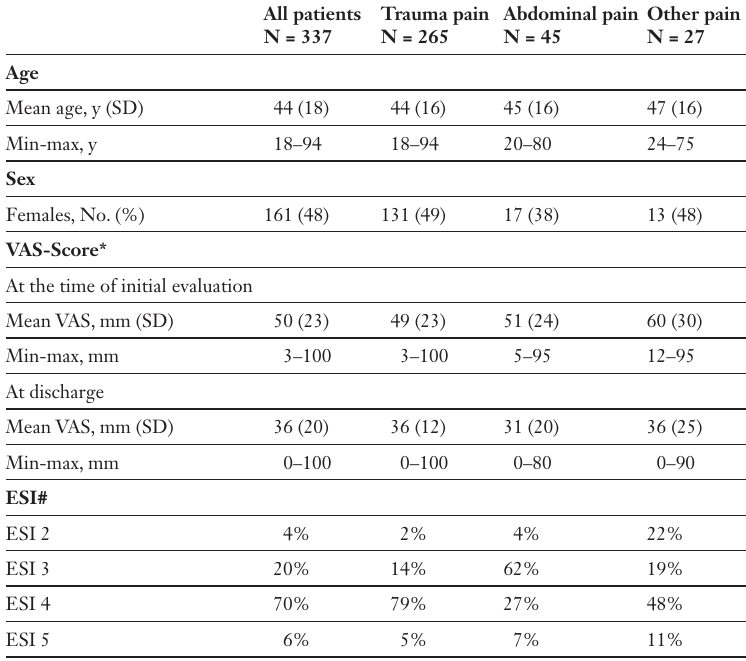
Table 1 Patient characteristics